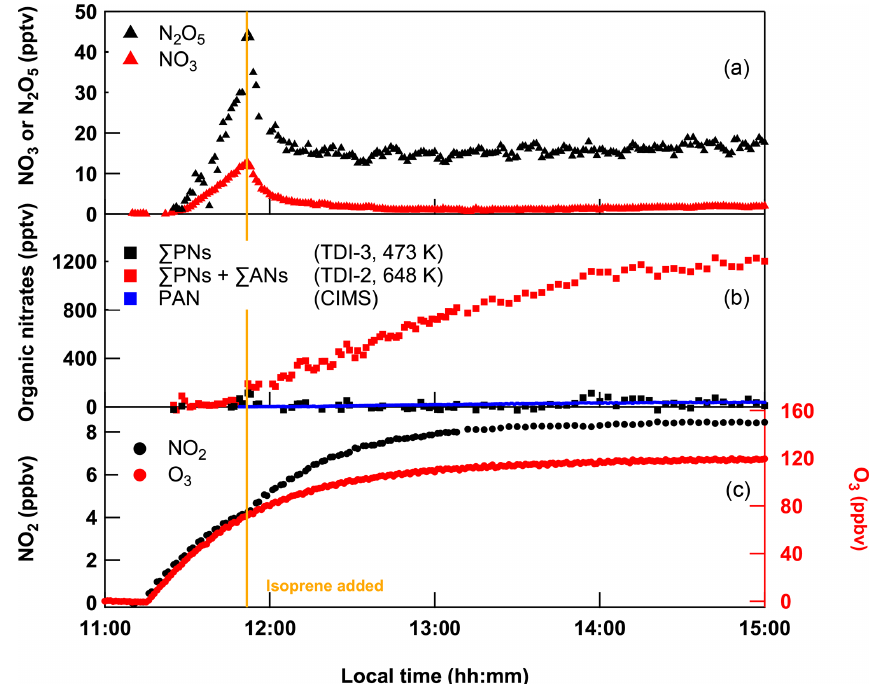
Figure 12. Mixing ratios of NO 2 , (cid:54) PNs with TDI-3 and (cid:54) PNs + (cid:54) ANs with TDI-2 obtained from constant introduction of 200sccm NO 2 , and 9.8sccm isoprene in 25SLPM (of which 5SLPM was passed over a PenRay lamp to generate O 3 ) dry synthetic air into SCHARK. A CIMS measurement of PAN is appended (blue